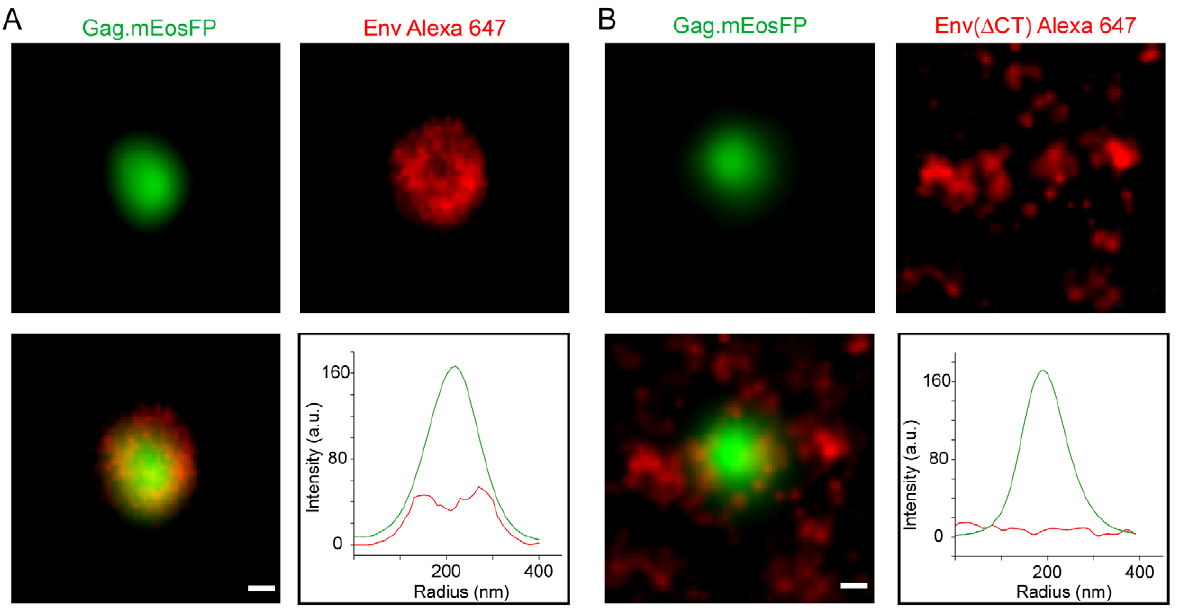
Figure 7. Averaged super-resolution intensity distribution of Env at HIV-1 assembly sites. Image-based, averaged assembly site analysis performed on super-imposed high-resolution images of individual Gag.mEosFP clusters (green) from cells transfected with pCHIV/pCHIV mEosFP ( A ) or pCHIV.Env( D CT)/pCHIV mEosFP Env( D CT) ( B ), respectively (n=7 assembly sites per condition) and the averaged Env Alexa Fluor 647 signal in the respective area (red). Graphs show the profile of intensity through the center of the averaged, overlaid intensity images: green line, Gag.mEosFP; red line, Env. Scale bars represent 50 nm.